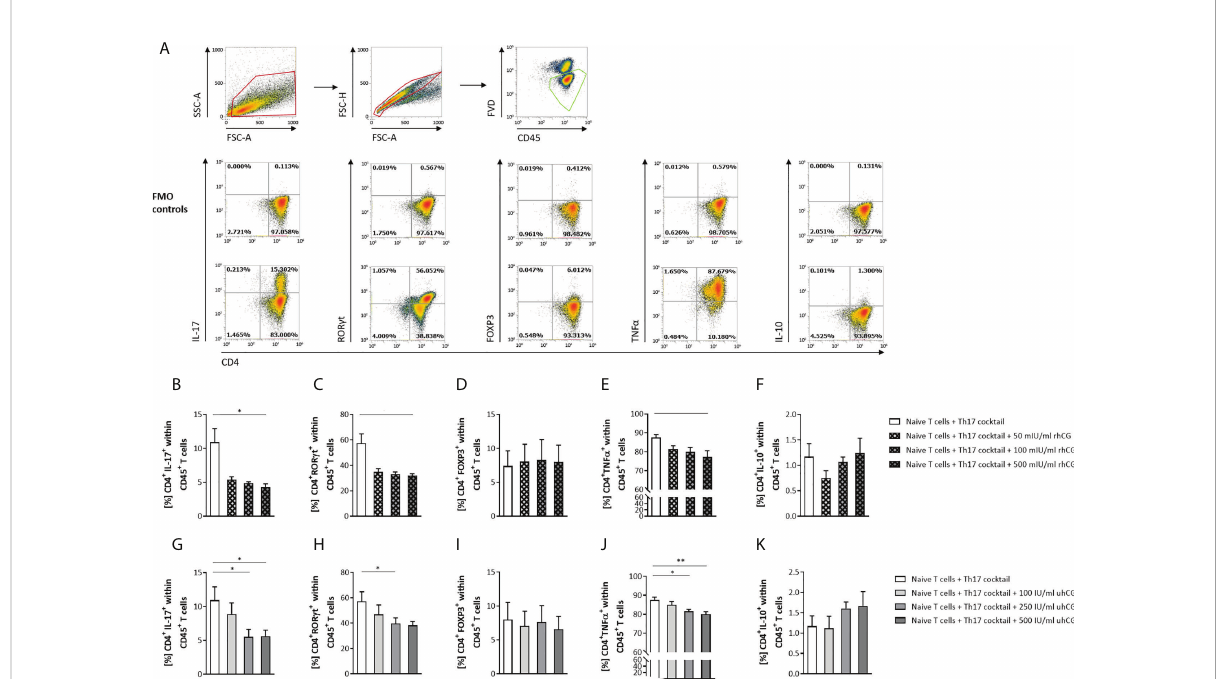
FIGURE 2 rhCG and uhCG interfered with Th17 differentiation in vitro. Naïve CD4 + T cells were isolated by magnetic-activated cell sorting (MACS) and polarized into Th17 cells under Th17-differentiating conditions for 3 days in vitro , in the presence of various concentrations of uhCG (100 IU/ml, 250 IU/ml and 500 IU/ml) or rhCG (50 mIU/ml, 100 mIU/ml and 500 mIU/ml), or absence of hCG as controls. Percentages of different T cell subsets as well as intracellular cytokine production were determined by fl ow cytometry. (A) Representative dot plots showing the gating strategy and fl ow-cytometric results of control FMO staining and full staining for all marker molecules except for the lineage markers CD4 and CD45. (B – K) Graphs showing the percentages of CD4 + IL-17 + , CD4 + ROR g t + , CD4 + FOXP3 + , CD4 + TNF a + and CD4 + IL-10 + cells within CD45 + T cells in the rhCG (B – F) or uhCG (G – K) treatment groups. Naïve T cells from WT ( n = 4) females mice were included in the assays. All assays were run in duplicate. Data are presented as the mean plus standard error of the mean (S.E.M.). Statistical analysis among groups was performed using the Friedman test followed by Dunn ’ s multiple-comparison test. Following, means plus S.E.M. are provided for signi fi cant differences between groups for CD4 + IL-17 + : 10.93 ± 1.989 vs 4.267 ± 0.5118 (w/o hCG vs 500mIU rhCG), 10.93 ± 1.989 vs 5.543 ± 1.069 (w/o hCG vs 250IU